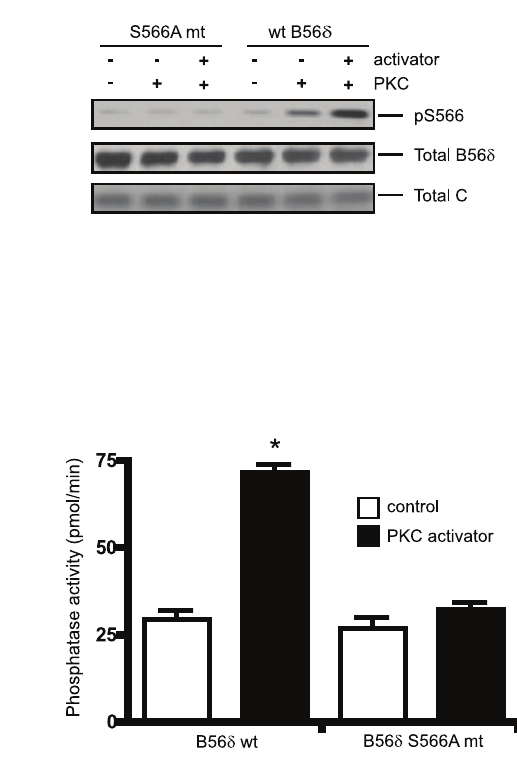
Figure 3. PKC activates PP2A/B56 d in vitro. FLAG-B56 d wt or FLAG-B56 d S566A mutant were expressed in N2a cells and active heterotrimeric complexes were immunoprecipitated from cell lysates using anti-FLAG antibody. Immunoprecipitated PP2A was mixed with purified PKC without (control) or with PKC activators (0.1 mg/ml phosphatidylserine, 0.02 mg/ml diacylglycerol, 0.2 mM CaCl 2 ) and Mg ATP for 10 min. (A). Phosphorylation at Ser566 of B56 d was assessed by immunoblotting using anti-phospho-Ser566 antibody. As a loading control, total B56 d subunit and co-immunoprecipitated PP2A C subunit were assessed by immunoblotting. (B). Immobilized PP2A was suspended in phosphatase assay buffer then PP2A activity was measured using a phospho-peptide substrate (Promega, 5 min assay). Phosphatase activity is shown as means 6 s.e.m. (n=3). *, P , 0.001, compared with no PKC activator control by student’s